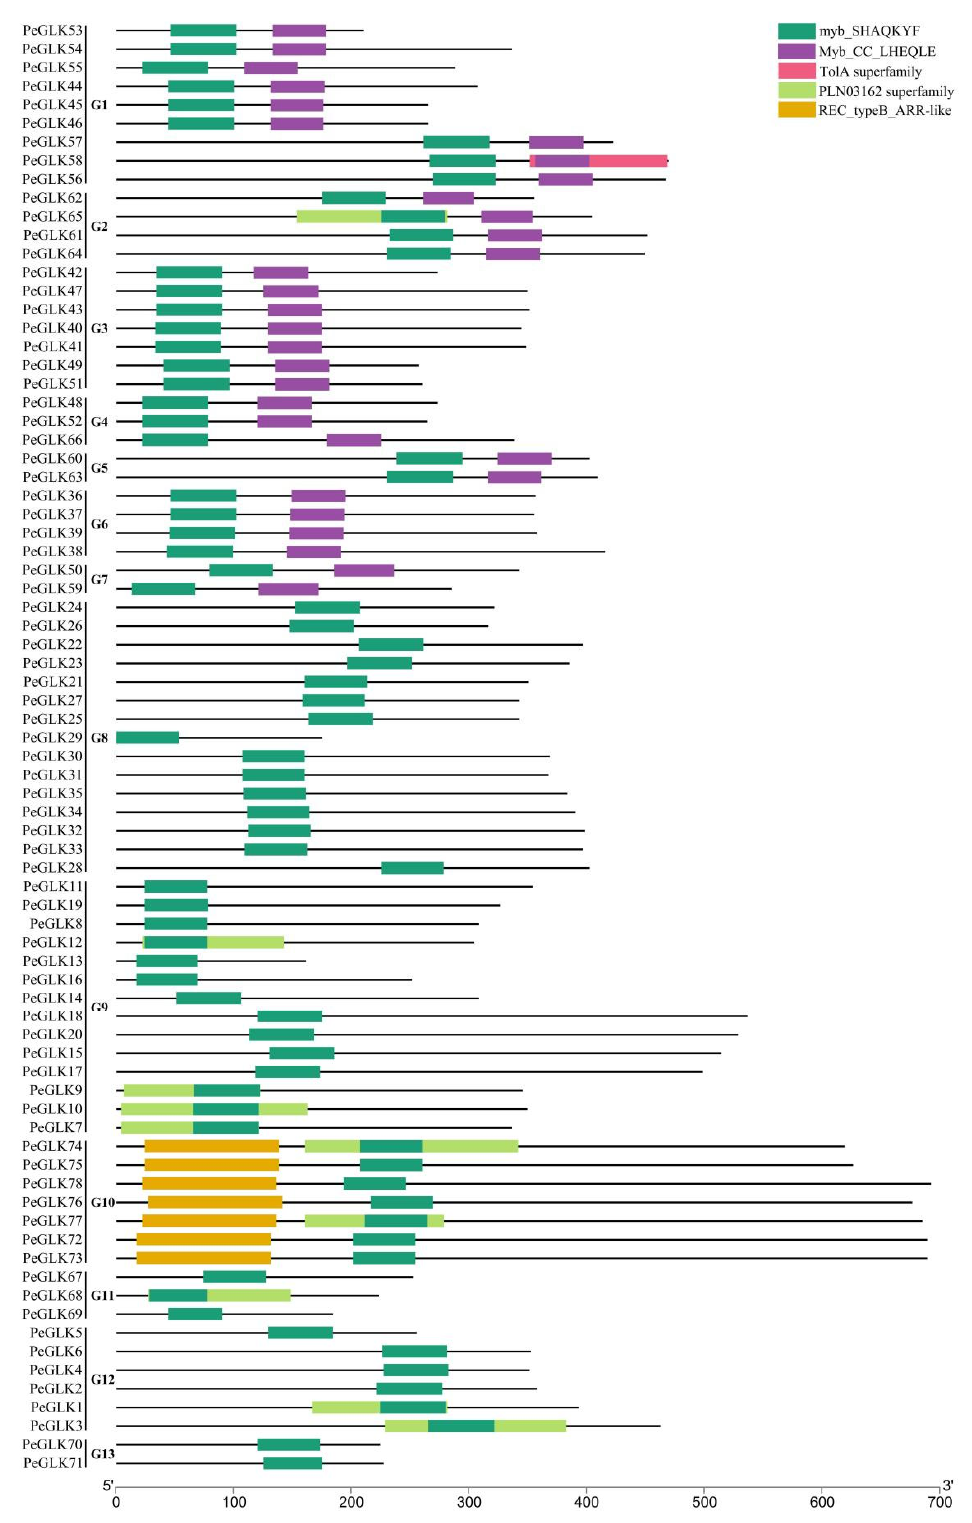
Figure 1. Division of 78 PeGLK genes into 13 groups (G1–G13) based on predicted domain structures. Domains are represented by different colored boxes.